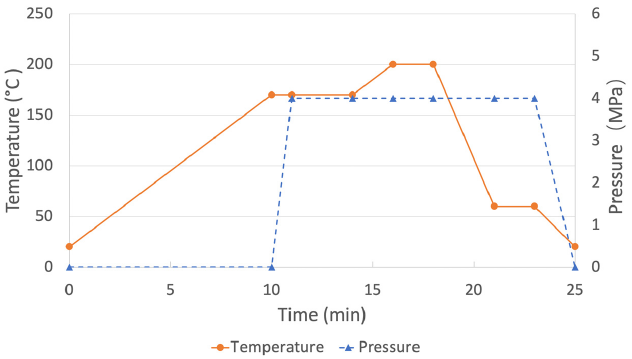
Figure 3. Schedule of thermo-hydro-mechanical (THM) treatment. Closing speed 3 mm s − 1